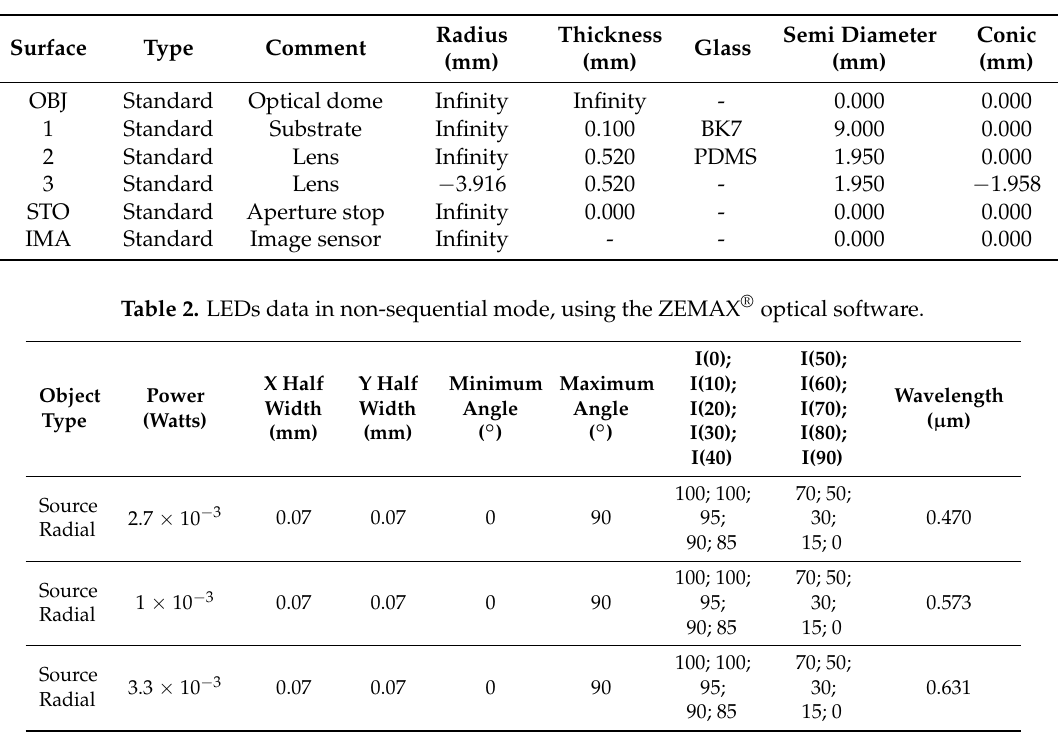
Table 1. The µ -lens data in sequential mode, using the ZEMAX ® optical software. OBJ: object. STO: stopping. IMA: image. BK7: optical borosilicate glass.